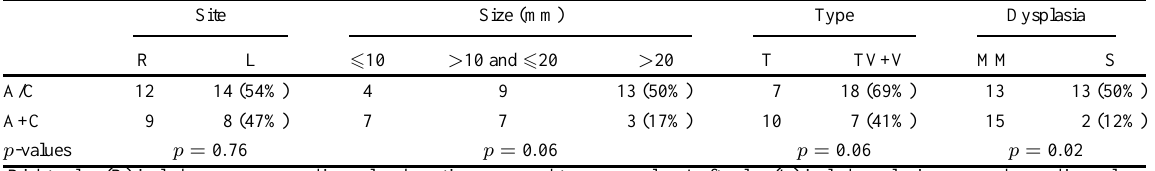
Comparison of site, size, type, and dysplasia grade for 26 colorectal adenomas containing early cancer (A/C) and 17 adenomas having cancer in the near vicinity (A+C). Type and dysplasia of A/C lesions refer to their adenomatous components (A)